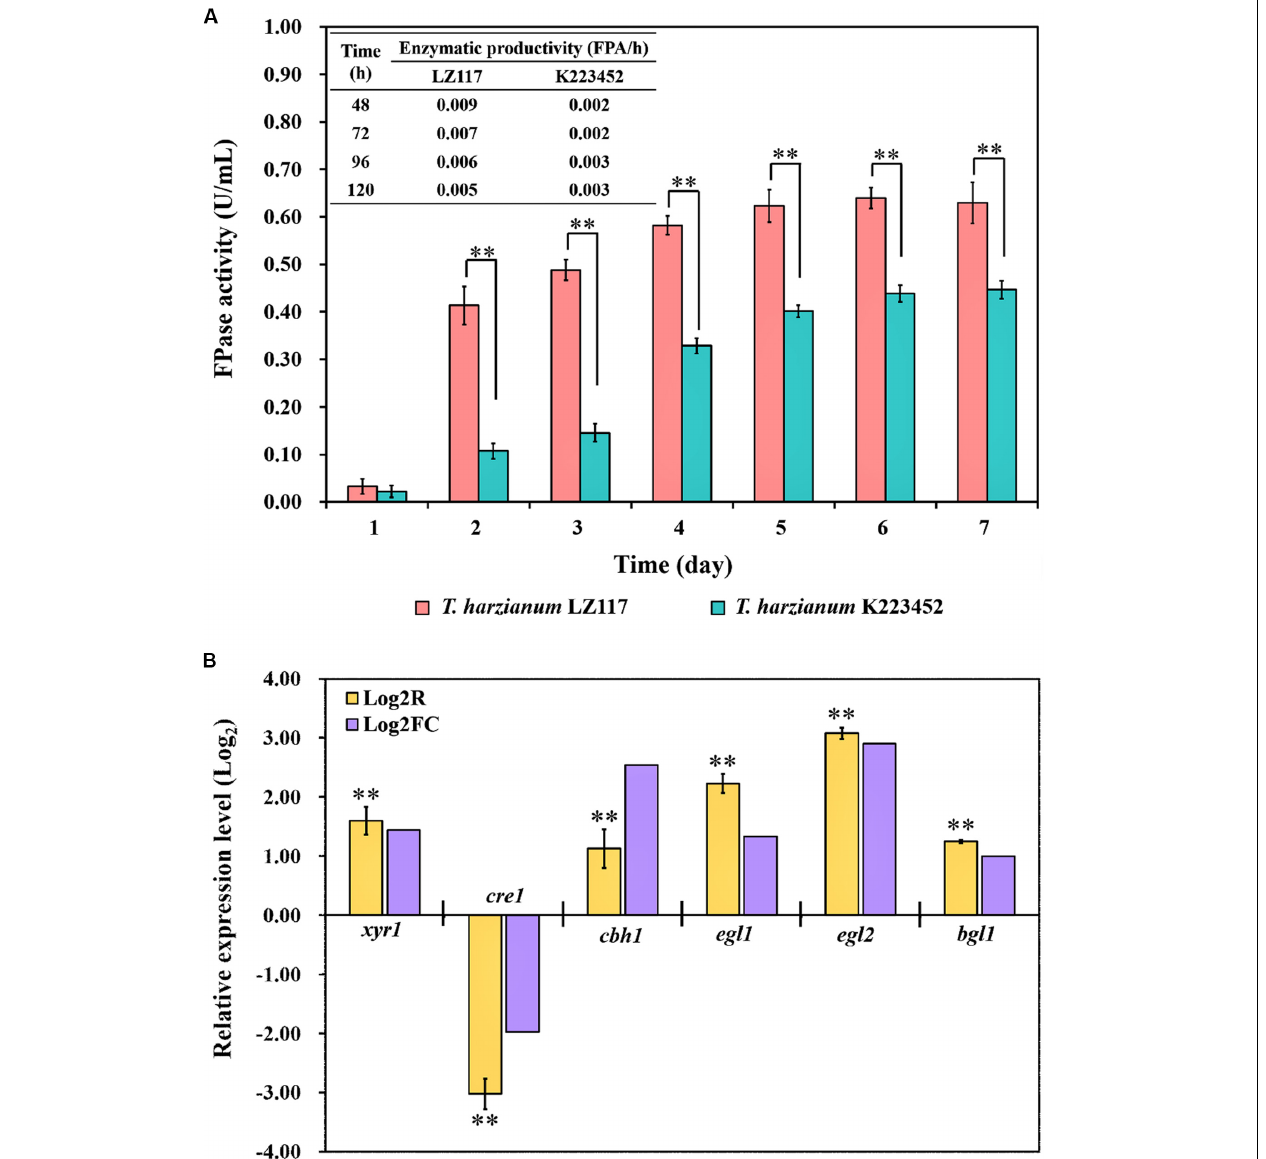
FIGURE 2 | Cellulase production of T. harzianum strains and validation of the transcriptome analysis. (A) Cellulase production profiles [FPA (U/mL) and productivity (FPA/h)] of T. harzianum LZ117 and T. harzianum K223452 cultured in shake flask using MA medium supplemented with 0.1% peptone and 2% microcrystalline cellulose. (B) Verification of the RNA-Seq data by RT-qPCR analysis using the selected genes encoding cellulolytic enzymes and transcription factors in T. harzianum LZ117 at 24 h (Log 2 R and Log 2 FC indicate results for RT-qPCR and RNA-seq, respectively). Error bars show the standard deviations, and the differences between groups were considered significant at p < 0.01 (Student’s t -test) and are indicated by ∗∗